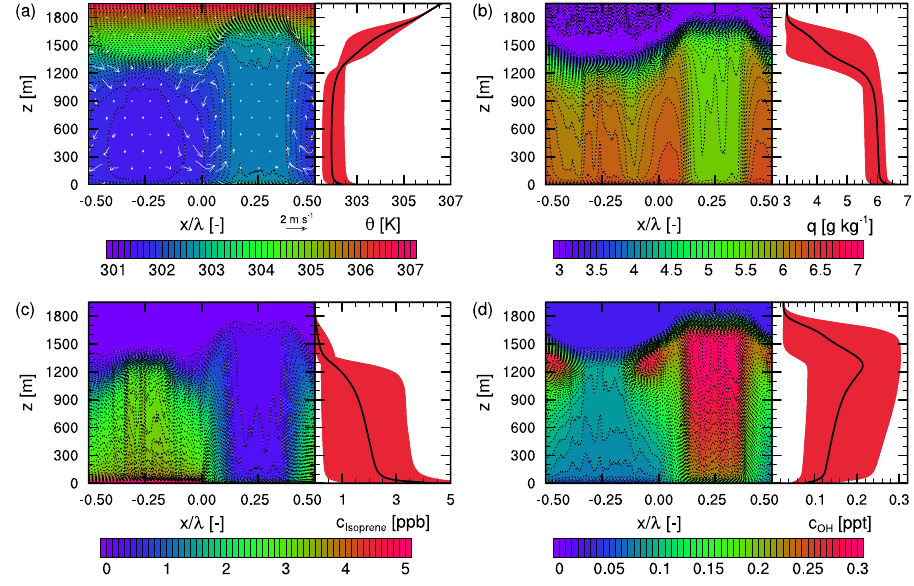
Fig. 11. The potential temperature (a) , specific humidity (b) , isoprene concentration (c) and OH concentration (d) for the fourth hour of the numerical experiment LSB2. The length scale of heterogeneity, λ , is 51.2km, which is equal to 33.5 times the averaged boundary layer height during this period. Each figure consists of two panels. The first panel shows the variables averaged over the fourth hour of simulated time and the y-direction, while the second panel shows an additional average in the x-direction. The red area in the second panel shows the variability in the x-direction of the temporal and y averaged values. Wind direction and magnitude are indicated by vectors (a)